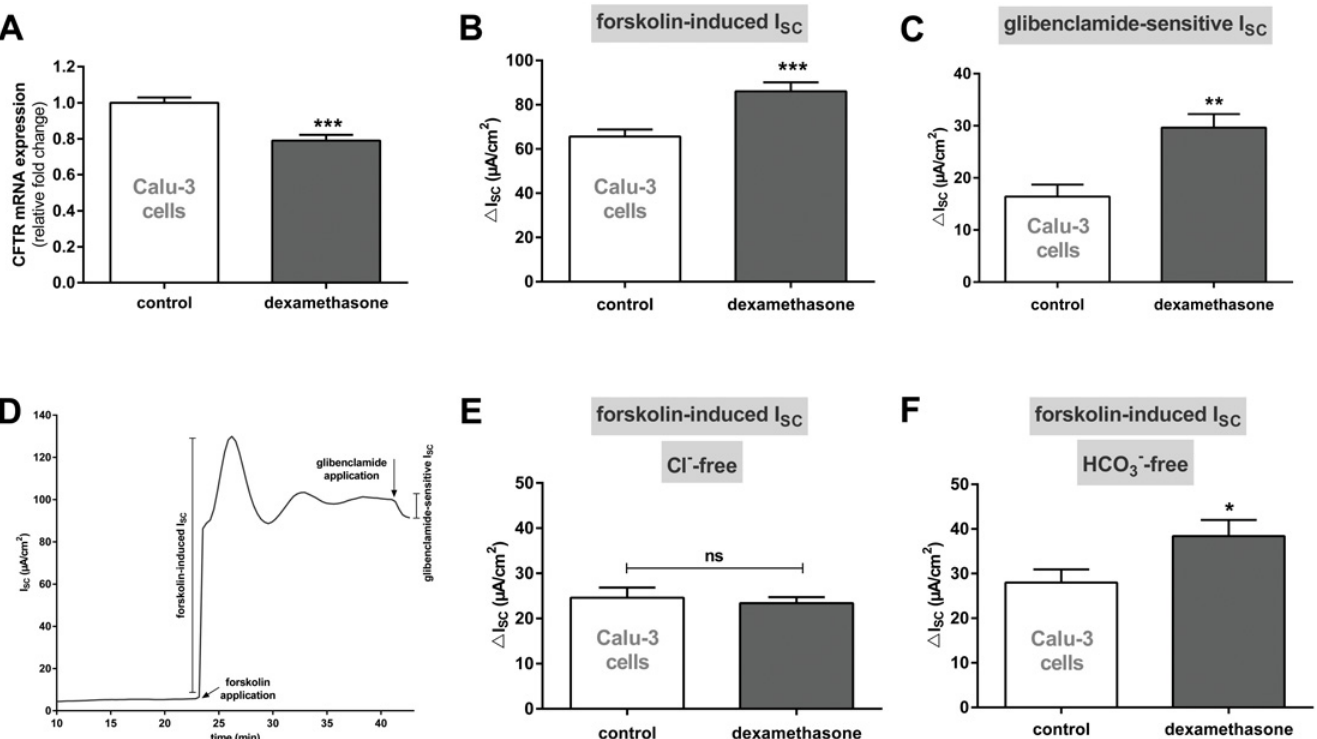
Fig 5. Dexamethasone reduces CFTR mRNA expression and increases channel activity in Calu-3 cells. A: Graph represents the mean + SEM for normalized CFTR mRNA expression in response to 100 nM dexamethasone for 24 h acquired by RT-qPCR (n = 6, *** p < 0.001, T-test compared to control cells without dexamethasone addition). B/C/E/F: Graphs represent the mean + SEM of I SC in response to 100 nM dexamethasone for 24 h measured in Ussing chambers. B: Forskolin-induced I SC (n = 12, *** p < 0.001, T-test compared to control cells without dexamethasone addition). C: Glibenclamide- sensitive I SC (n = 6, ** p < 0.01, T-test compared to control cells without dexamethasone addition). D: Typical current tracing of Calu-3 cells. E: Forskolin- induced I SC measured in Cl - -free solution (n = 14 – 16, ns = not significant). F: Forskolin-induced I SC measured in HCO 3- -free solution (n = 16, * p < 0.05, T-test compared to control cells without dexamethasone